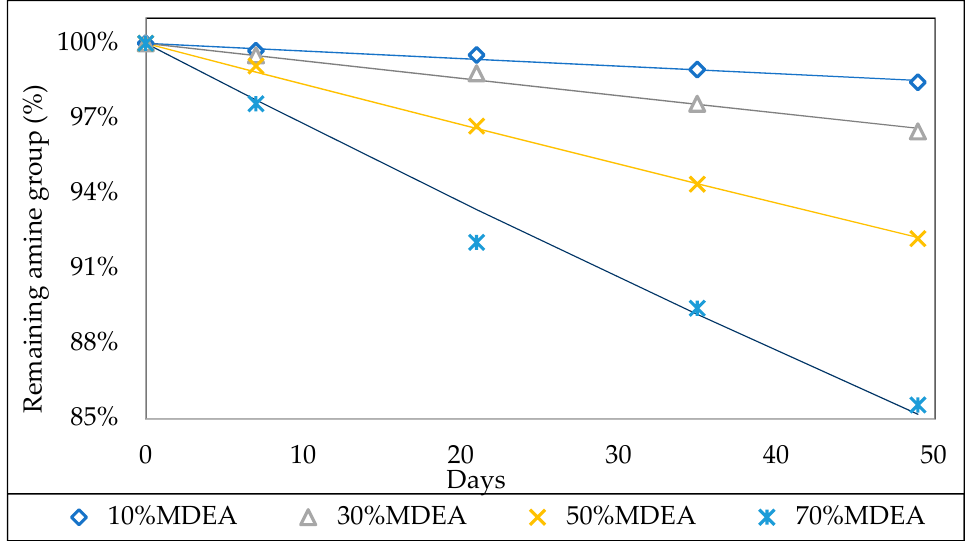
Figure 10. Remaining amine group (%) in various aqueous N -methyl diethanolamine (MDEA) solutions, with solid lines representing the model results at CO 2 loading ≈ 0.4.